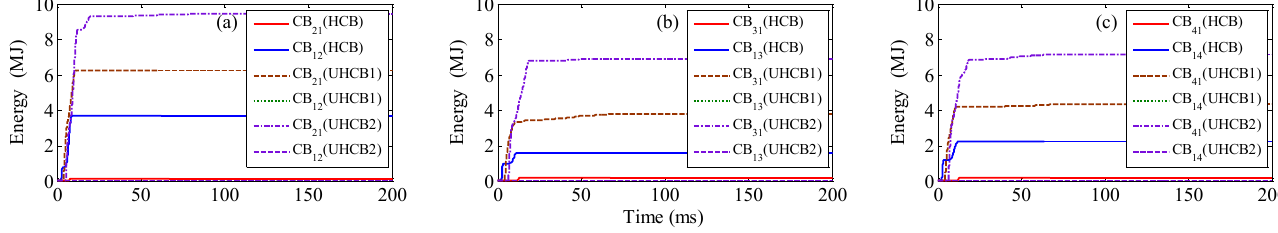
Fig. 9. Absorbed energy in surge arresters of BCBs and UCBs (a) CB 12 and CB 21 , (b) CB 13 and CB 31 , (c) CB 14 and CB